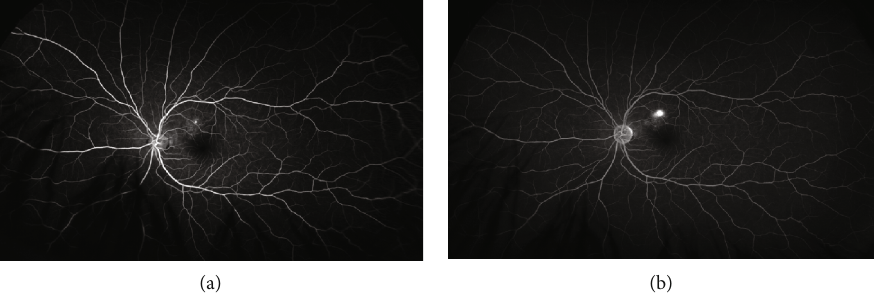
Figure 1: Fluorescein angiography with focal leakage, sometimes called an expansile dot. (a) Early phase. (b) Late phase.